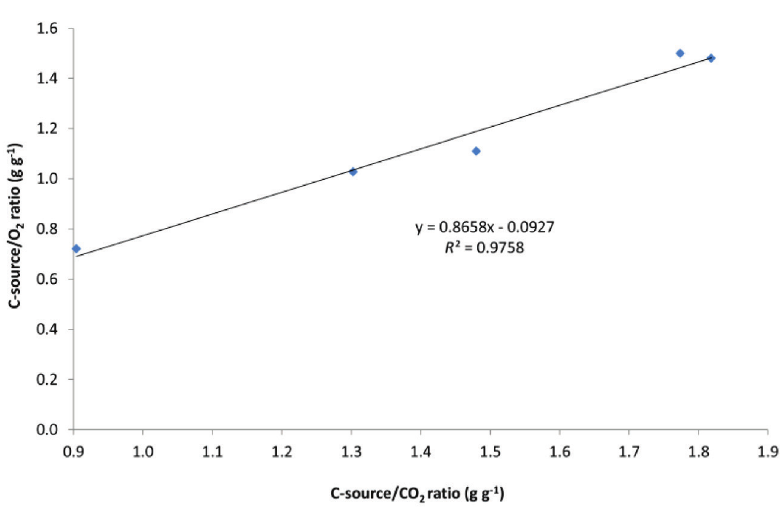
Fig. 3 – Relationship between C-source/O nential growth phase, data from cultivations 1 –